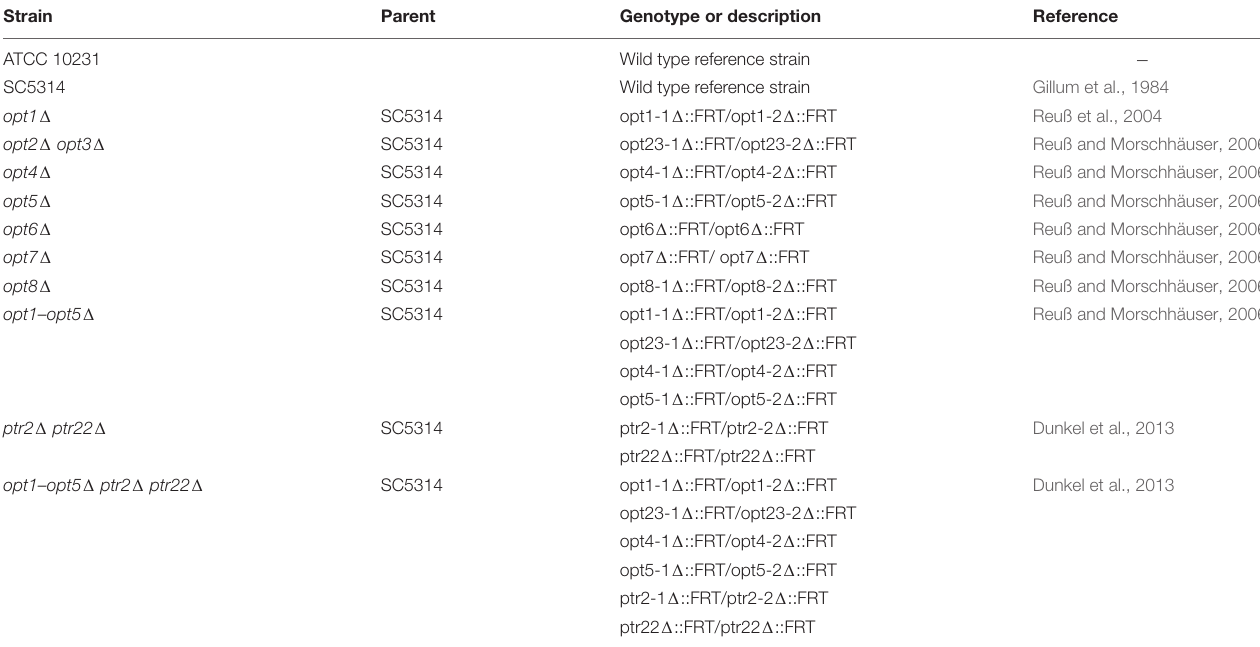
TABLE 1 | Candida albicans strains used in this